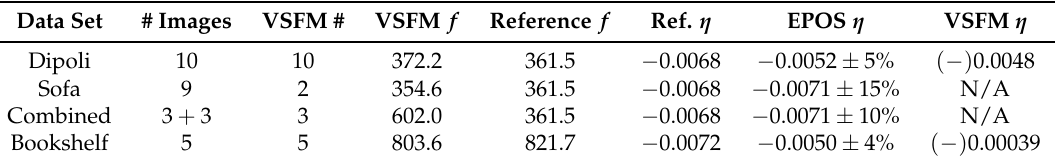
Table 2. EPOS results with real data using a confidence value of 0.99 are compared against the state-of-the-art VisualSFM (VSFM)